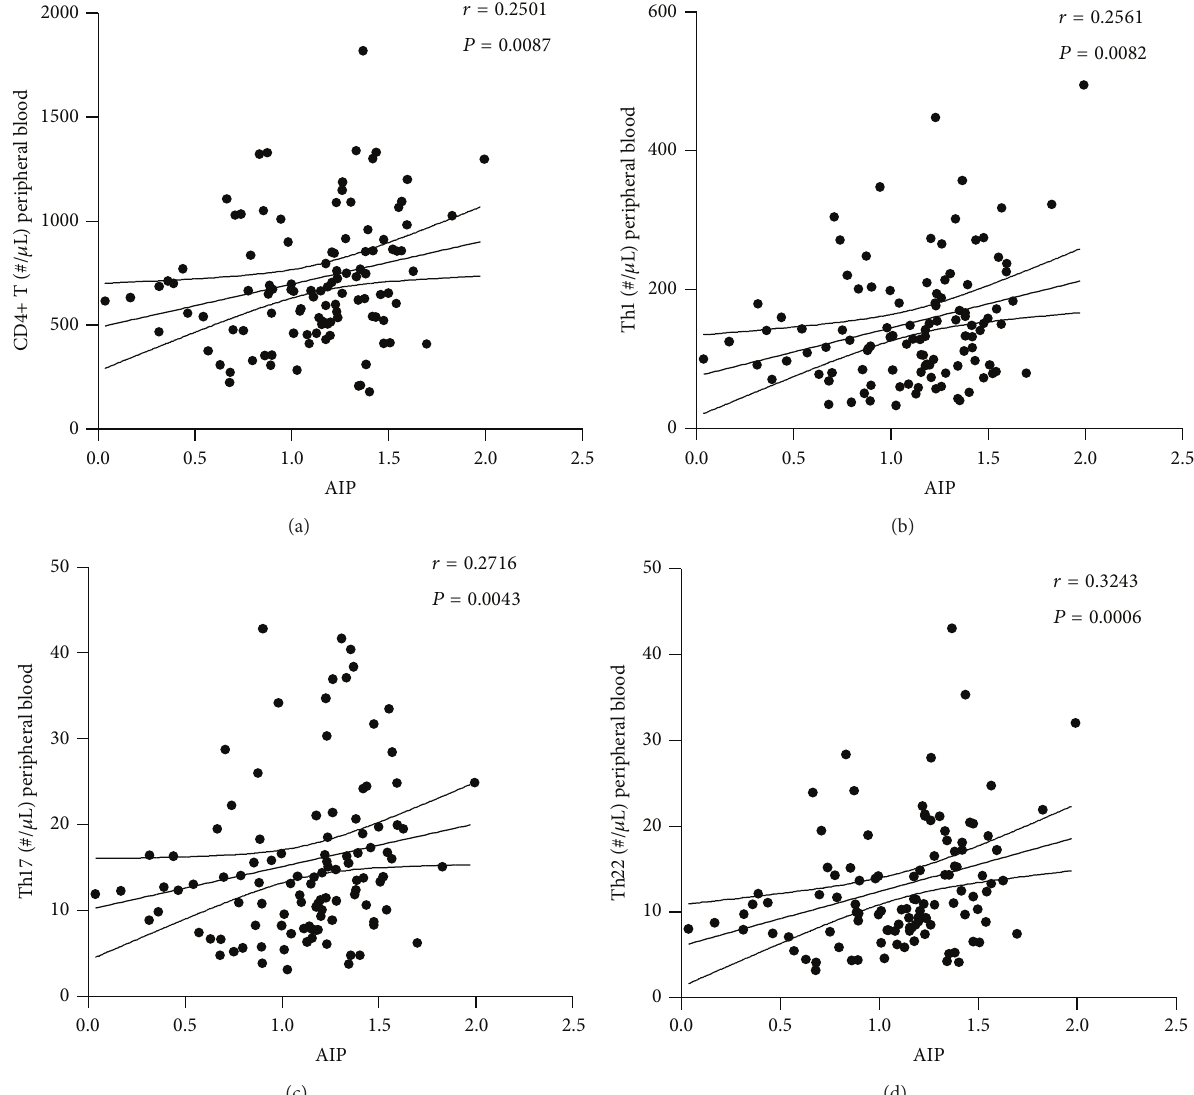
Figure 4: Correlation analysis of absolute numbers of Th22, Th1, and Th17 cells with AIP correlation analysis of the absolute numbers of proinflammatory Th subsets in peripheral blood with AIP in T2D patients. The total number of CD4+ T cells (Th cells) showed a significant positive association with AIP. The positive correlation of Th1, Th17, and Th22 numbers, respectively, with AIP was all proved to be statistically significant (b, c, and d). Numbers in each figure show Spearman 𝑟 and 𝑃 value, respectively.